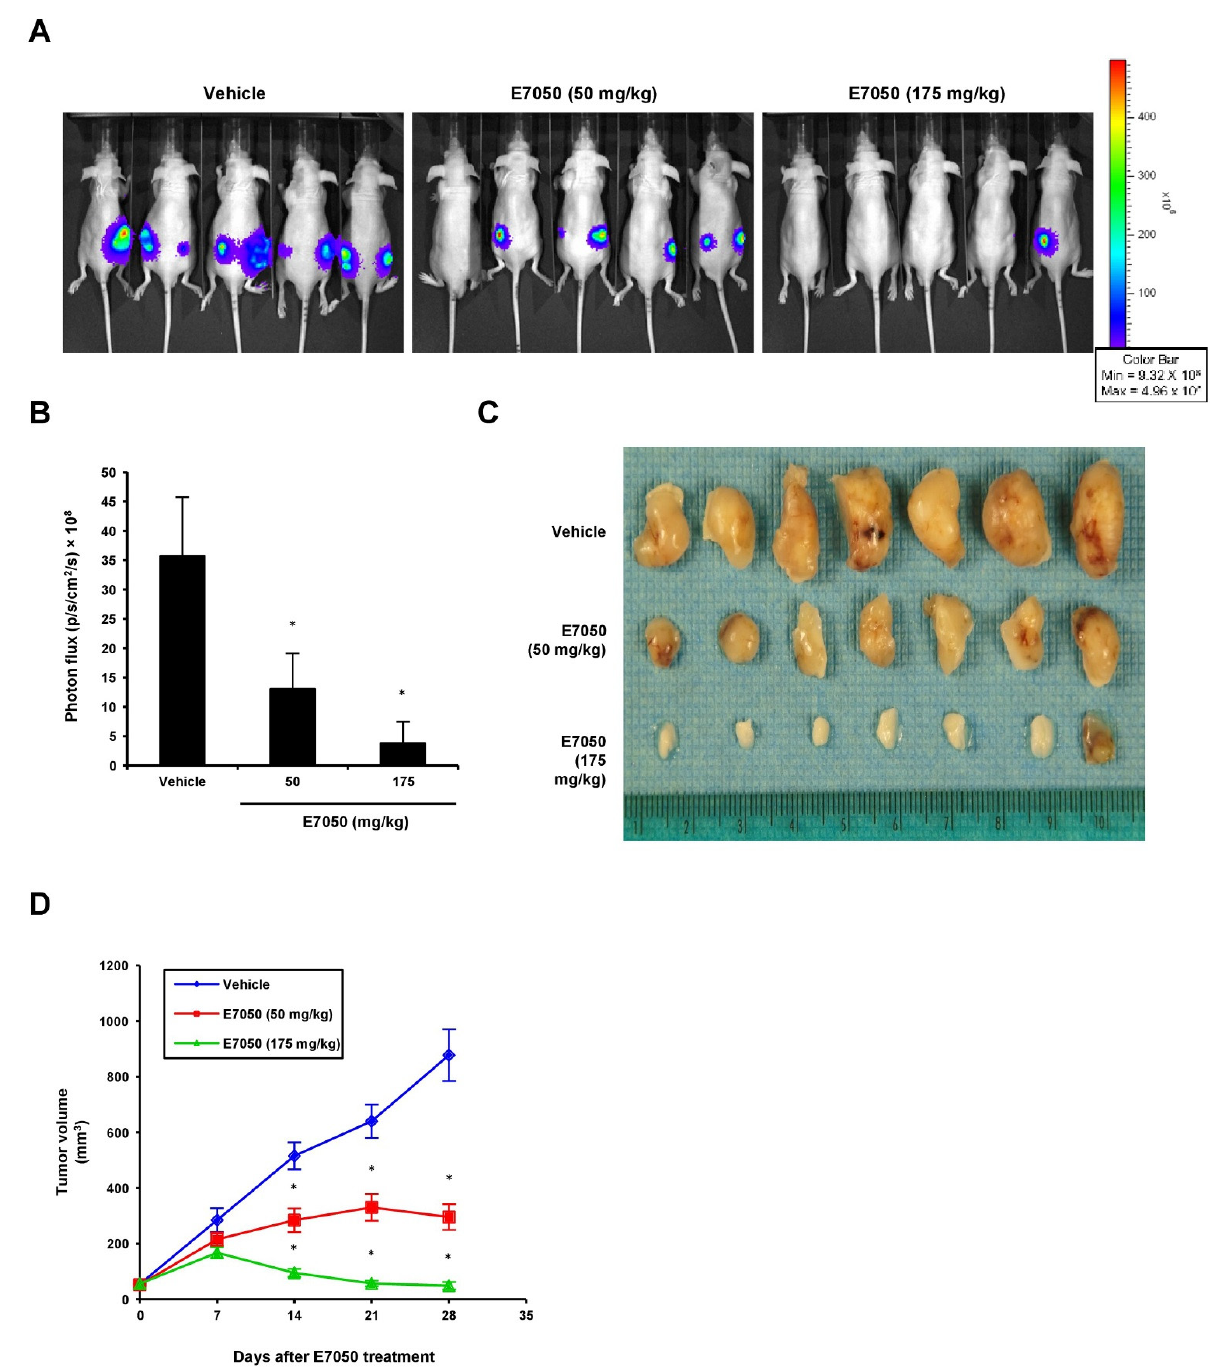
Figure 6. Effects of E7050 on the growth of MES-SA/Dx5 subcutaneous xenograft tumors in nude mice. Nude mice bearing MES-SA/Dx5-LG xenograft tumors were treated daily with vehicle or E7050 at 50 and 175 mg/kg for 28 days. ( A ) Representative bioluminescence images of five mice from each group are shown using an IVIS Imaging System. The color scale represents photon flux (photons/s/cm 2 /steradian). ( B ) Emitted bioluminescence (p/s/cm 2 /s) from vehicle- and E7050-treated mice representing tumor growth at day 28. ( C ) The image shows the tumor size of MES-SA/Dx5 xenografts from vehicle- and E7050-treated groups at the end of the experiment. ( D ) Volume (mm 3 ) of developing MES-SA/Dx5 xenograft tumors in vehicle- and E7050-treated mice was measured at days 7, 14, 21 and 28. Data are expressed as the mean ± SEM ( n = 5 per group). * p < 0.05 compared with the vehicle control